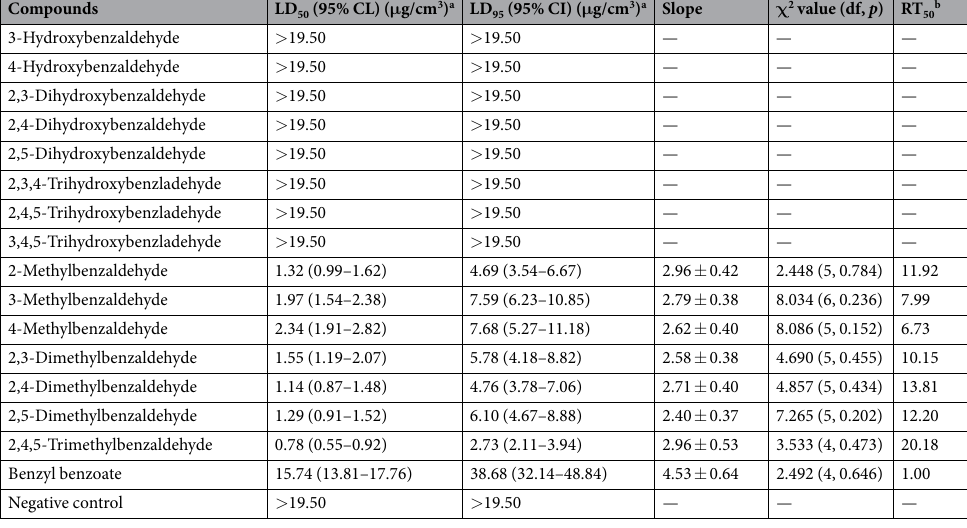
Table 4. Acaricidal toxicity of hydroxybenzaldehyde analogues, methylbenzaldehyde analogues and synthetic acaricide against T . putrescentiae , using a vapor bioassay ( a LD 50 /LD 95 is the average of 5 determinations,